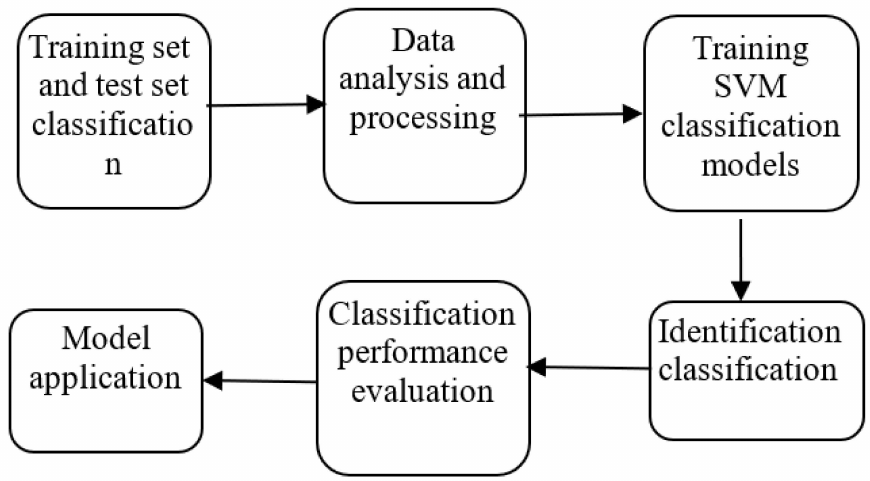
Figure 5. Flowchart of support vector machine